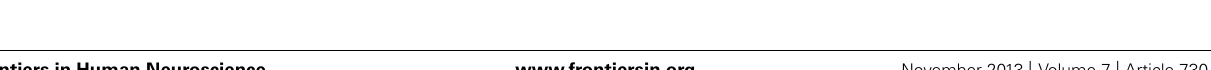
Frontiers in Human